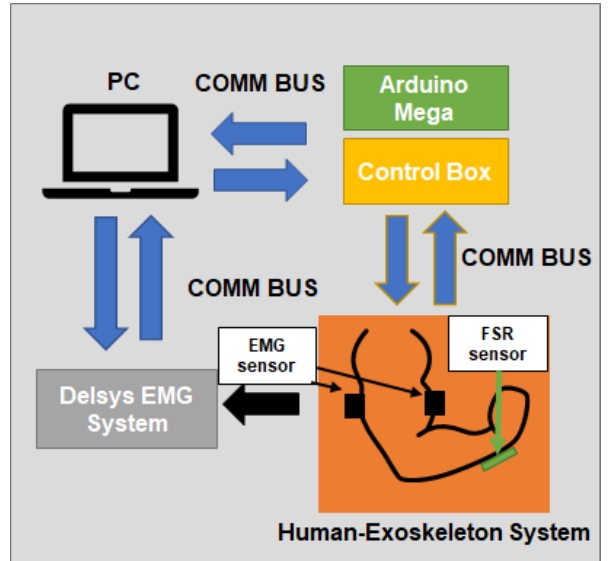
Figure 7. Interface